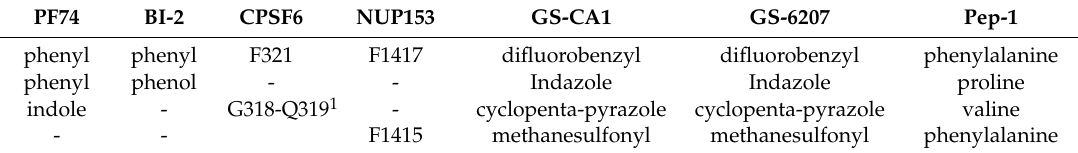
Table 1. Structural similarity among PF74, PF74-based compounds and host